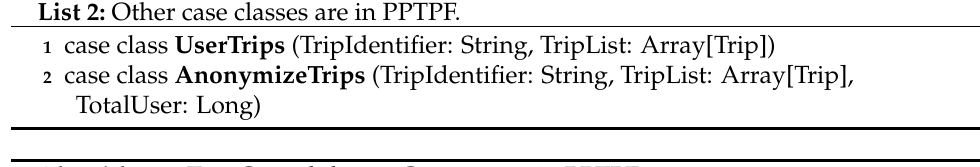
Algorithm 3: Trip Consolidation Component in